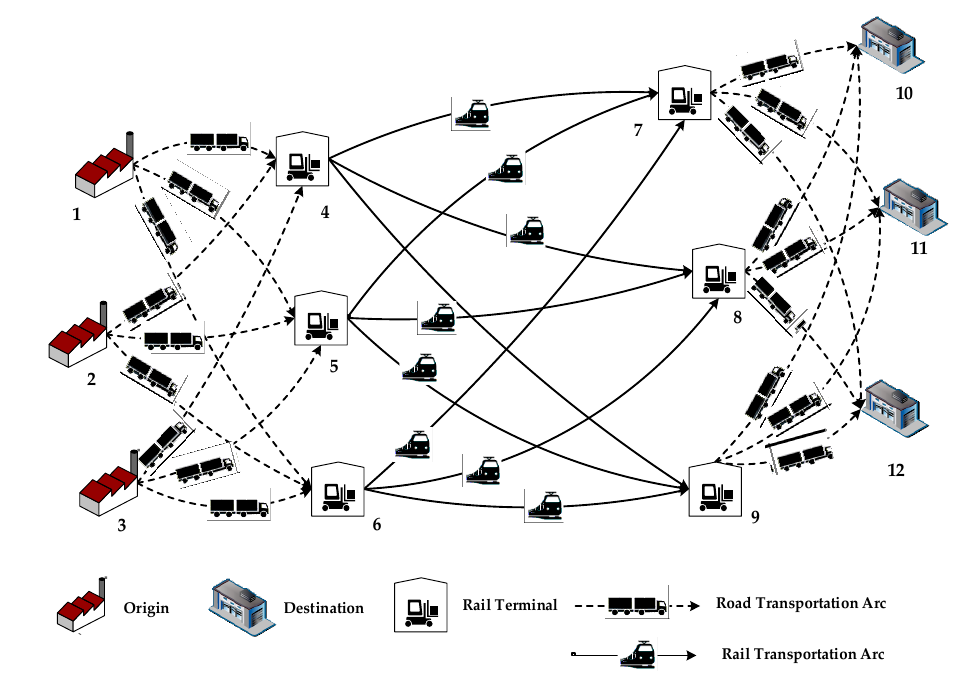
Figure A1. A road-rail intermodal hub-and-spoke network. Figure 1A. A road-rail intermodal hub-and-spoke network. Table A1. The schedules of the container trains in the Table 1A. The schedules of the container trains in the network.